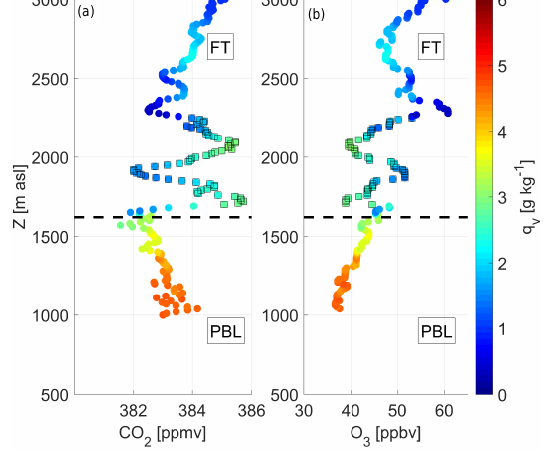
Figure 7. Vertical profiles of (a) CO 2 and of (b) O 3 in the morning (07:27UTC) on 6 September 2011. The colour shows the specific humidity, and the horizontal lines show the boundary layer height (black dashed line) and the residual layer height (dashed grey line).